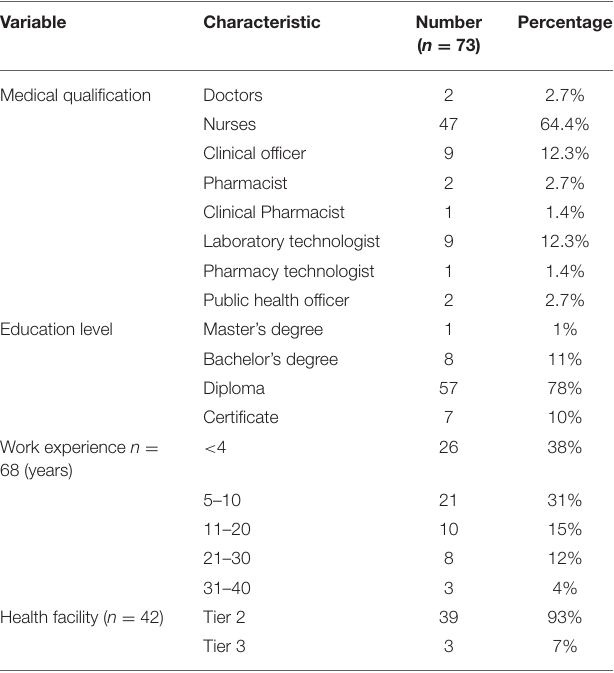
TABLE 1 | Socio-demographic characteristics of healthcare workers that participated in the study.